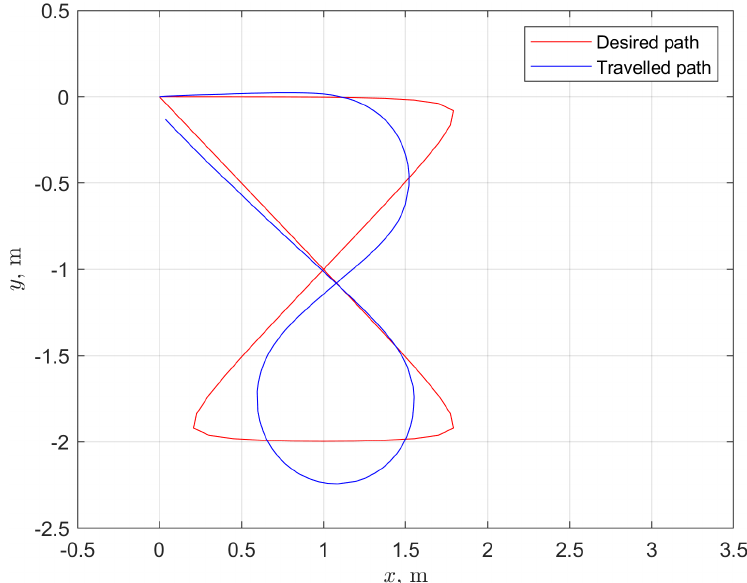
Figure 26. Desired path vs. actually traveled path for the lowest value of the cost function equal to 0.8369—track 2.